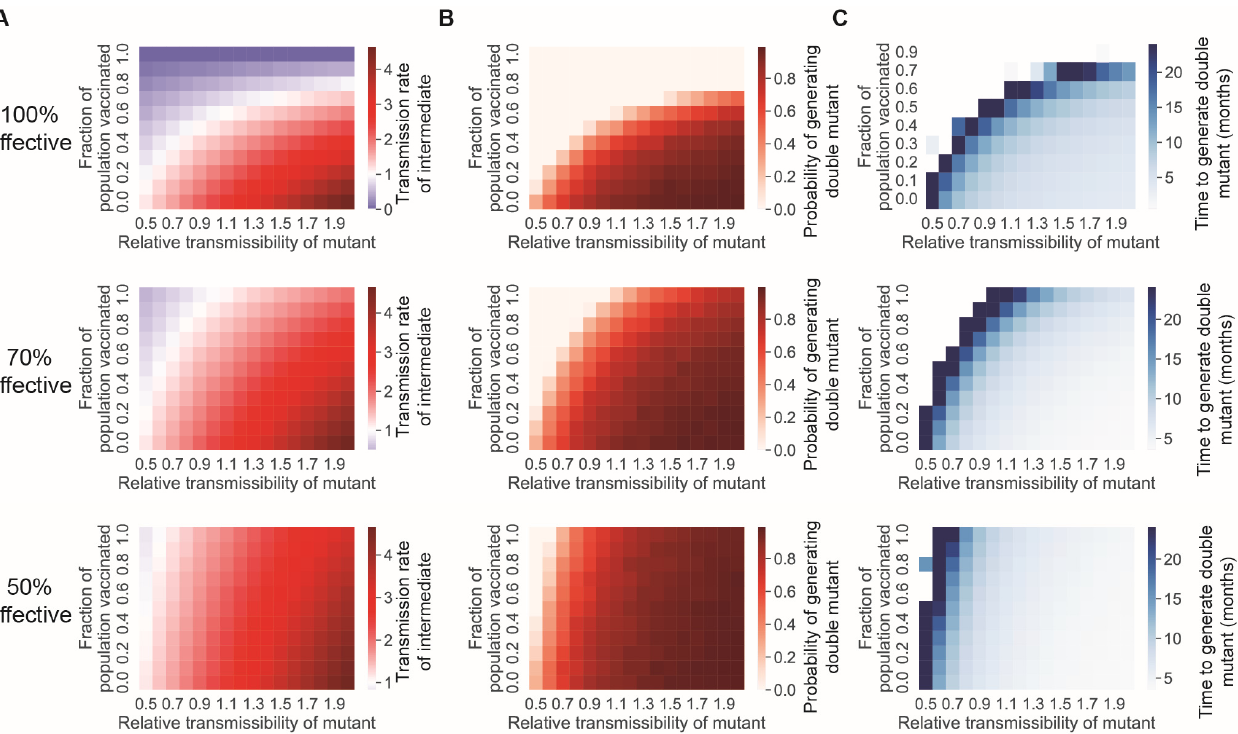
Figure 2. Vaccination can lower the rate at which new variants appear by lowering the effective transmission rate. ( A ) The effective transmission rates of single mutants, given different coverage fractions of a completely effective vaccine, for a 100%, 70%, or 50% effective vaccine against trans- mission. The x-axis denotes the transmissibility of the single-mutant variant, relative to the original WT transmission rate R T of 3.32. ( B ) Probability of generating a double-mutant lineage before the extinction of the single mutant. ( C ) Time to generate a double-mutant variant after the initial mutation occurs in one host, given that a double mutant eventually arises. For all panels, n = 10,000 simulation was run.